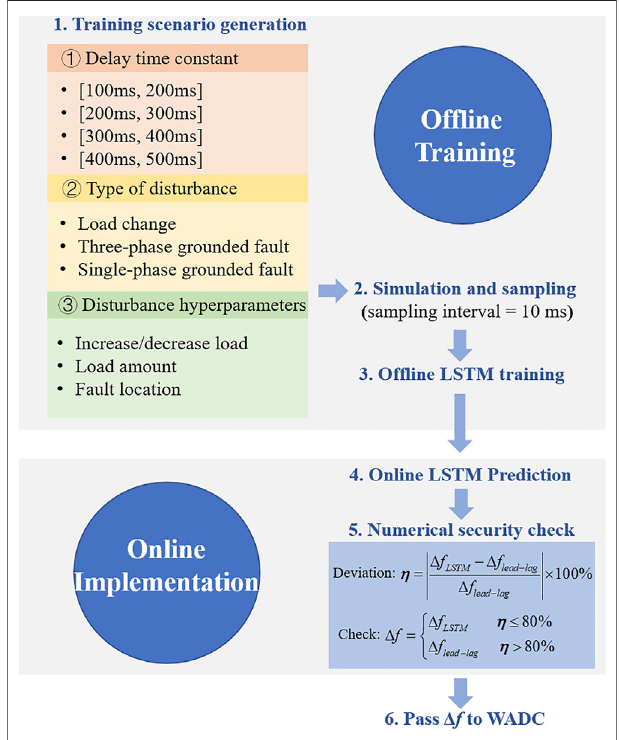
FIGURE 6 | Diagram of of fl ine training and online